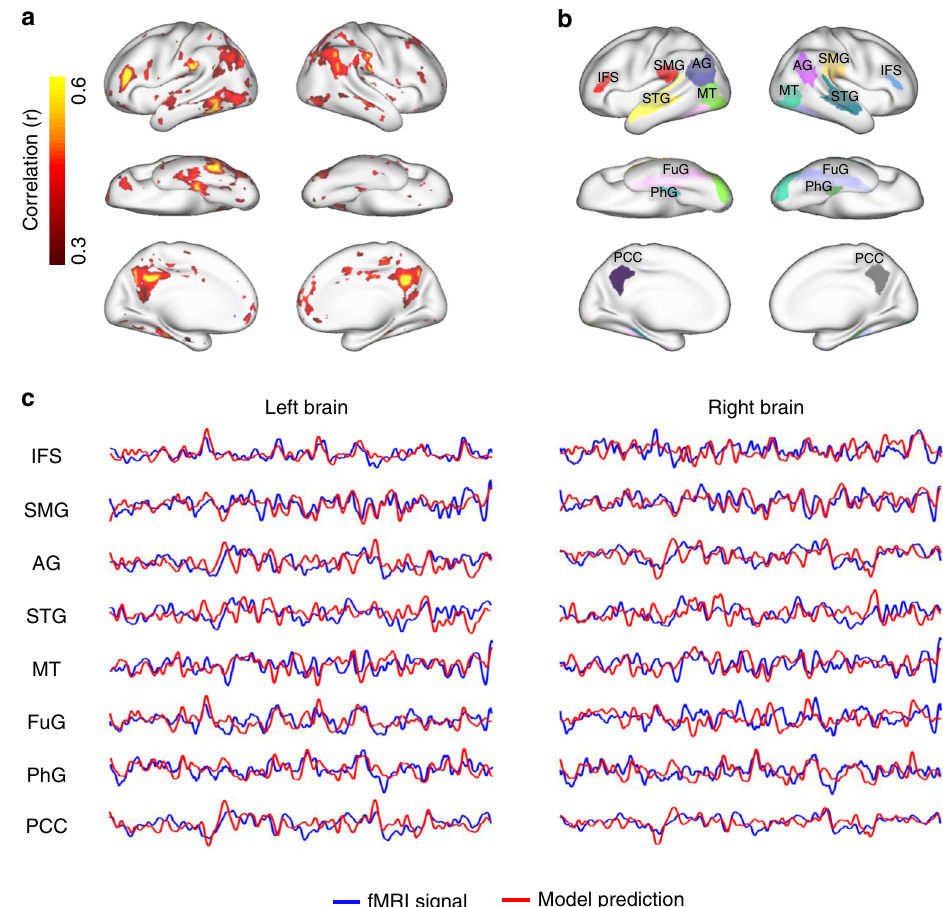
Fig. 3 Measured vs. model-predicted responses to a new (untrained) testing story. a The voxel-wise correlation between fMRI responses and model predictions for a 6 m 53 s testing story. The fMRI responses were averaged across subjects. Color indicates the correlation coef fi cient. The color- highlighted areas include the voxels of statistical signi fi cance (block-wise permutation test, one-sided, FDR q < 0 : 05). b Prede fi ned ROIs (shown in different colors) are displayed on the cortical surfaces. See details in Supplementary Table 2. c Response time series as measured (blue) or model-predicted (red) for each ROI, by averaging the time series across voxels within each ROI. IFS inferior frontal sulcus, SMG supramarginal gyrus, AG angular gyrus, STG superior temporal gyrus, MT middle temporal visual area, FuG fusiform gyrus, PhG parahippocampal gyrus, PCC posterior cingulate